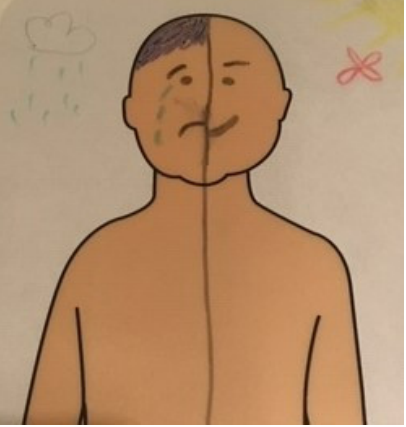
Figure 4. Relentless Feelings of Guilt and